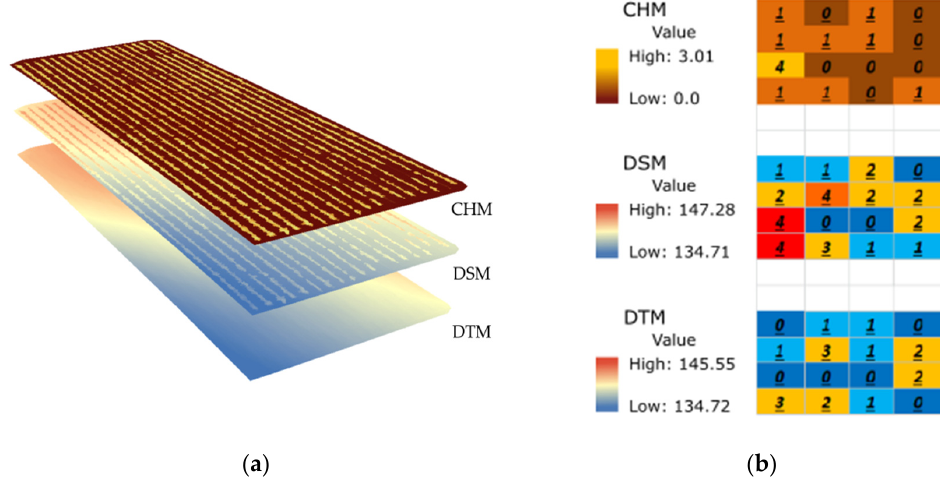
Figure 4. ( a ) The three-layer typologies used to obtain canopy volumes through ArcGIS; ( b ) an exemplification of the Canopy Height Model (CHM) derived from the difference between DSM and Digital Terrain Model (DTM) rasters. Each square represents a pixel with the relative altitude above the sea level (DSM and DTM) and height above ground (CHM). The CHM height values were used to calculate the rows’ volumes.